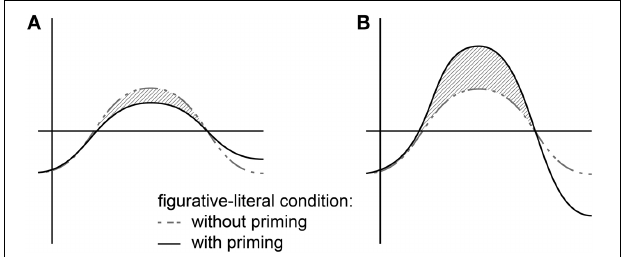
FIGURE 1 | Predictions for difference wave plots (figurative condition minus literal meaning) for condition with (gray dotted line) and without priming (black solid line) in the N400 time-window. Left panel (A) illustrates the indirect access view, right panel (B) the direct access